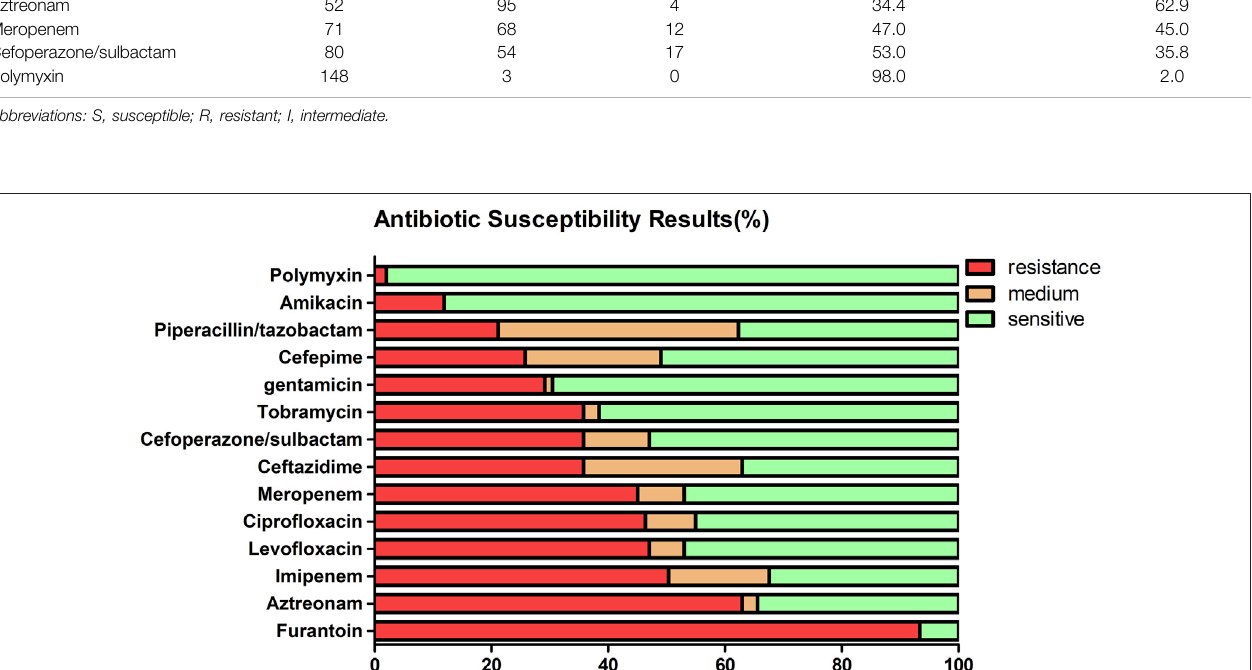
Frontiers in Pharmacology |